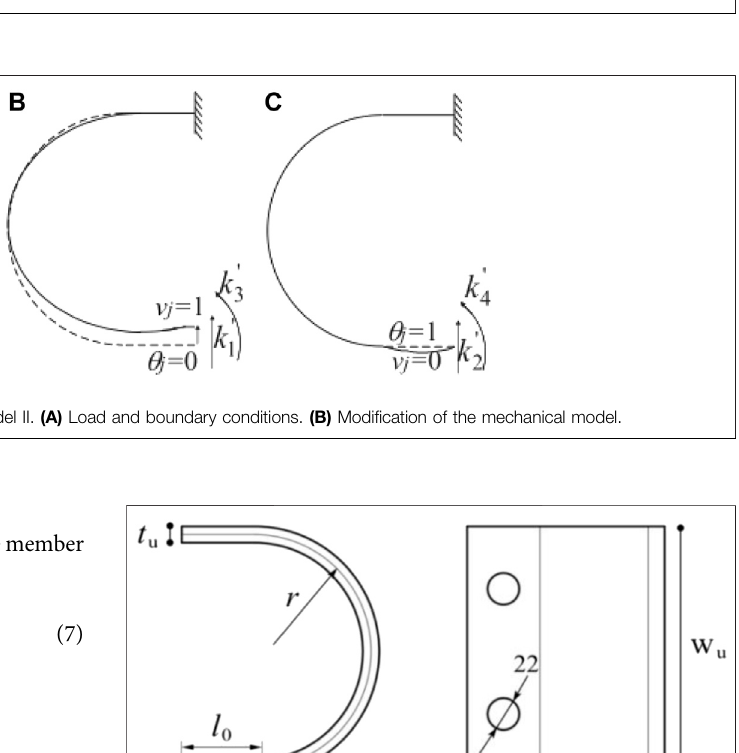
Frontiers in Materials |